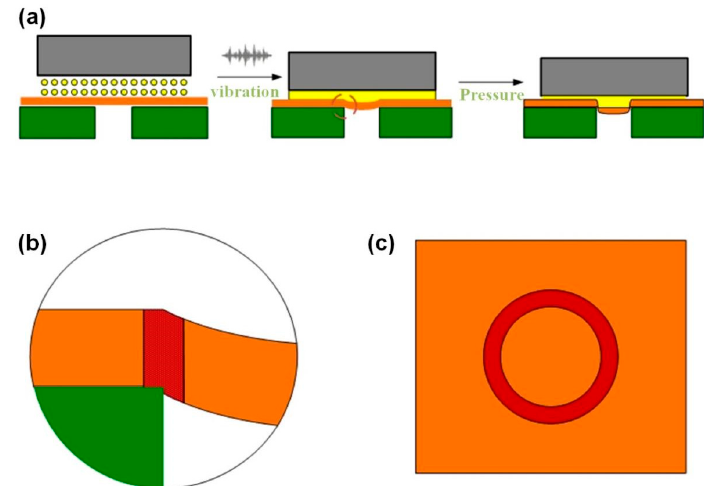
Figure 4. ( a ) Schematic diagram of shear punching of amorphous alloys under high-frequency vibration principle. ( b ) Schematic diagram of soft zone separation of amorphous alloy strips in shear punching of amorphous alloys under high-frequency vibrations process. ( c ) Amorphous alloy strip soft zone seen from a top view during shear punching of amorphous alloys under high-frequency